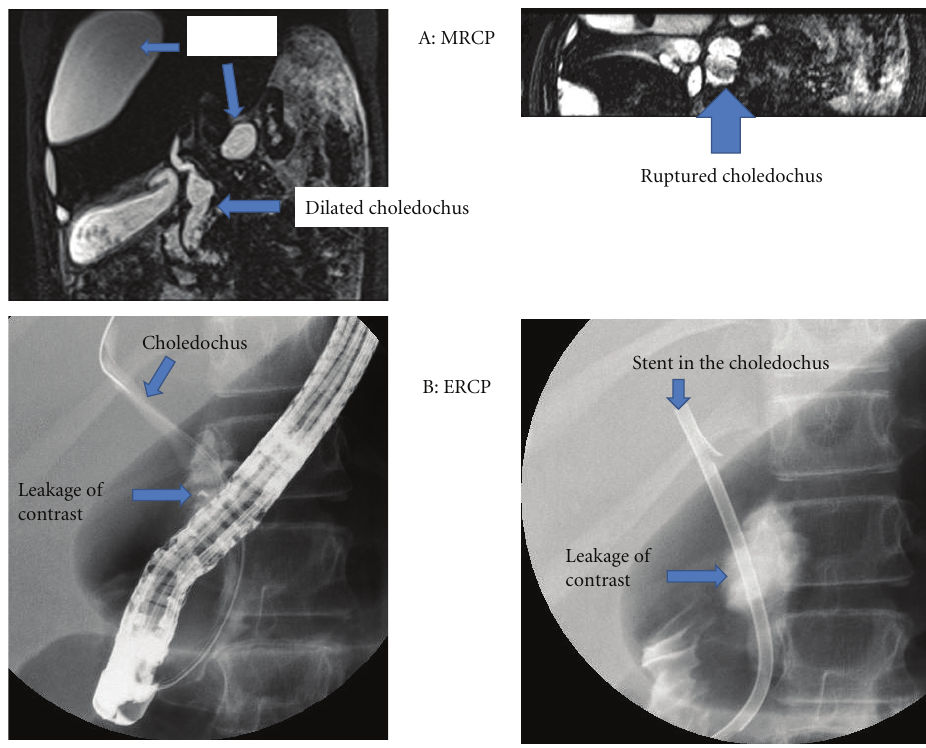
Figure 1: A: MRCP images demonstrating the subcapsular e ff usion, dilatated choledochus, and the choledochus rupture. B: ERCP images from leaking choledochus and stent placement.